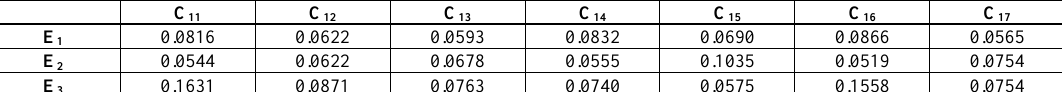
Table 7. The weighted normalized matrix for the criteria set (C 1